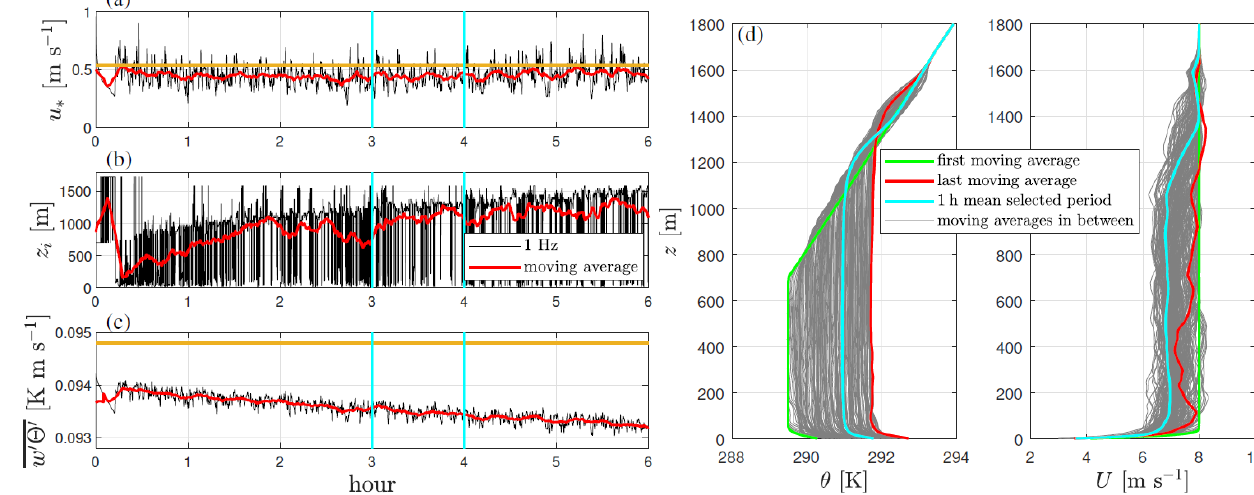
Figure 4. Similar to Fig. 3 but for the unstable ABL simulation. We replace the simulated wind speed at a model level by the simulated surface heat flux and add the observed heat flux as an ochre solid